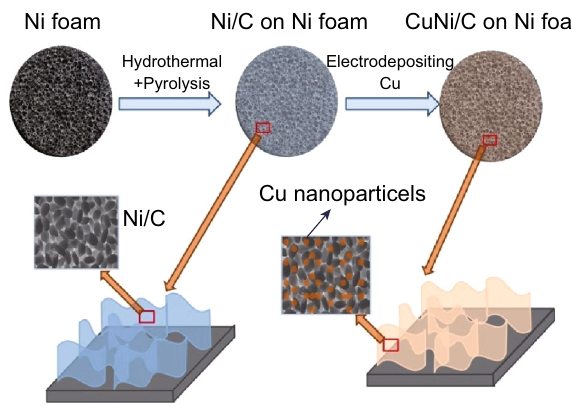
Fig. 1 Schematic diagram of preparing CuNi/C